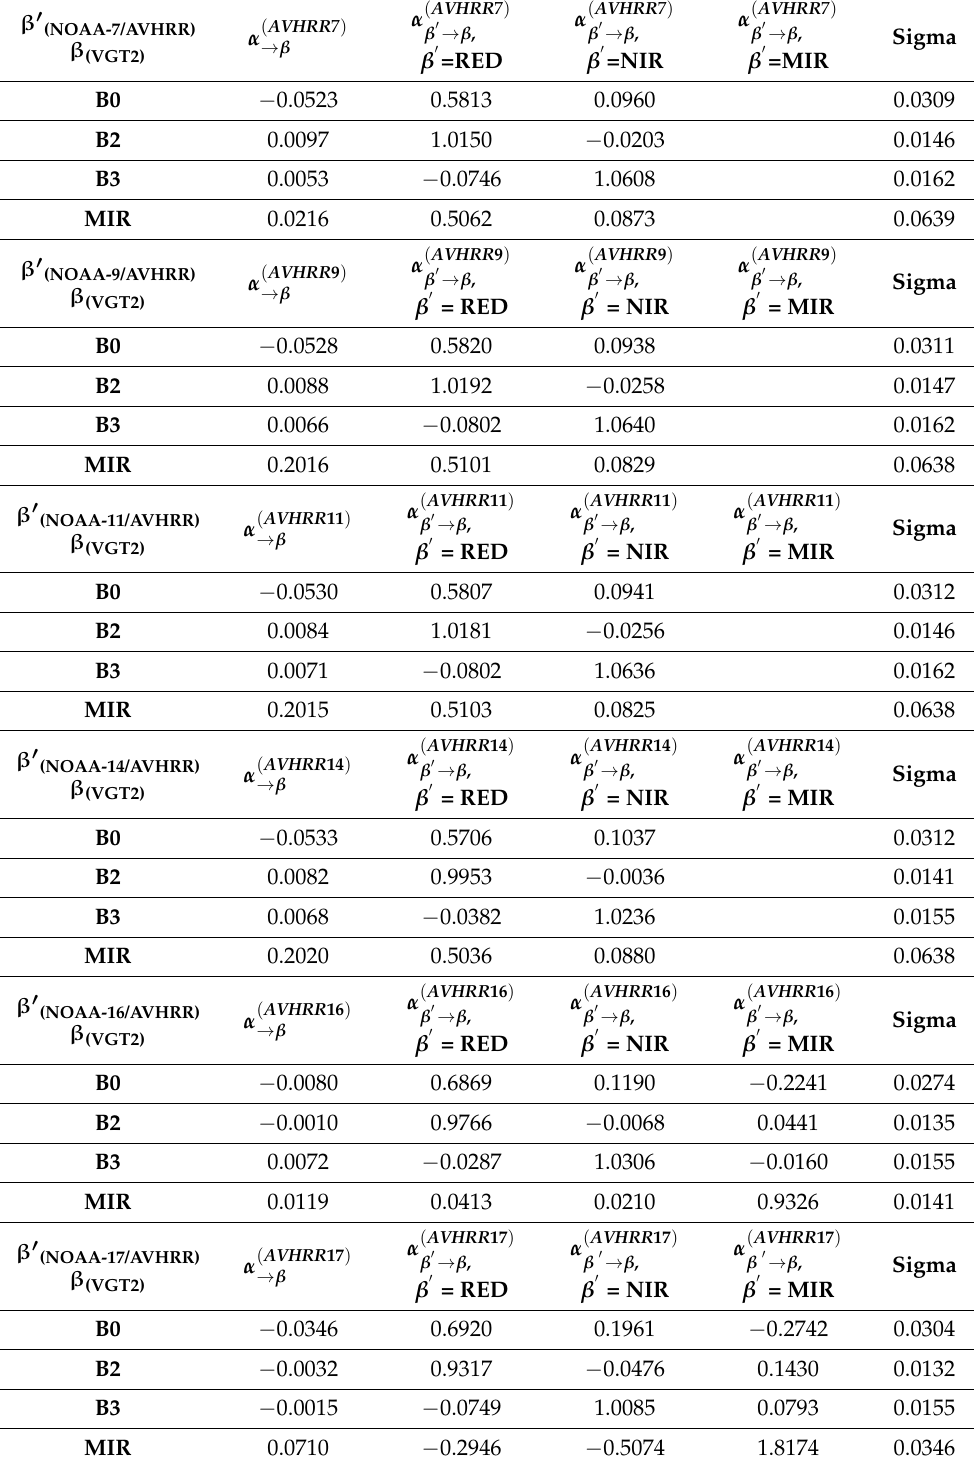
( AVHRRX ) ( AVHRRX ) Table A2. Coefficients ( α ) of each linear model → β in the first column and α β (cid:48) → β ( VGT 2 ) (Equation (1)) to predict the reflectance values R for the VGT-2 B0, B2, B3 and MIR bands from β ( AVHRRX ) the reflectance values R for the NOAA-X/AVHRR bands. The standard deviation resulting β (cid:48) from the regression is given in the last column. Only NOAA-7, 9, 11, 14, 16, 17 are considered. These coefficients are only valid for snow-free pixels. For pixels flagged with snow/ice, a different set of coefficients is used following the same approach based on snow ice spectra only (for more information see ATBD on